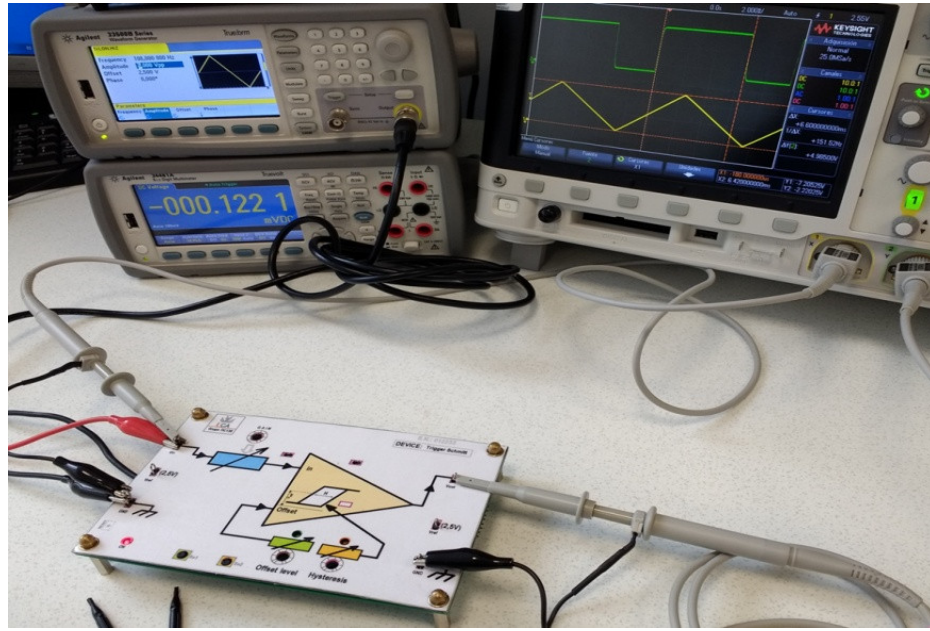
Figure 7. Schmitt-trigger circuit emulation.